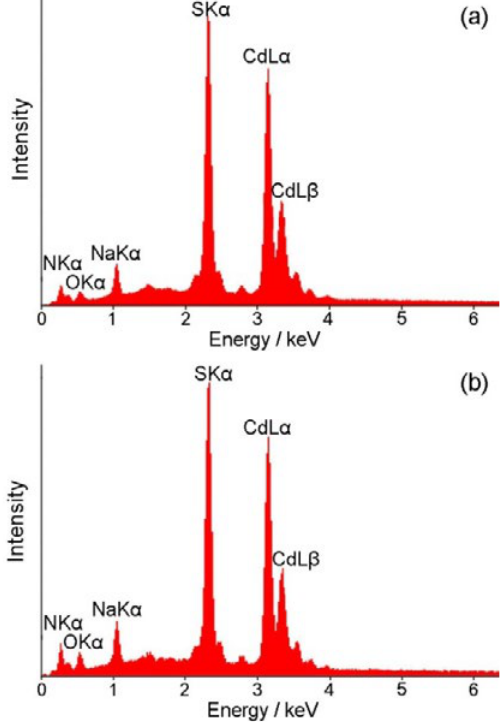
Fig. 4. EDX spectra of (a) L- and (b)